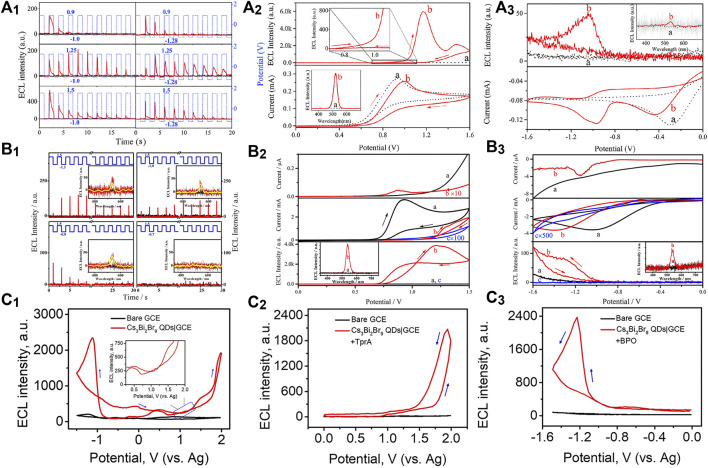

(A
1
) Oxidation initiated transient electrochemiluminescence (ECL), (A
2
) anodic coreactant ECL (10 mA TPrA), and (A
3
) cathodic coreactant ECL (5 mM BPO) of CsPbBr3 NCs|GCE in air-free dichloromethane containing 0.10 M tetra-n-butylammonium hexafluorophosphate (TBAPF6). Reproduced with permission from Huang et al. (2016). Copyright (2016) The Royal Society of Chemistry. (B1) Oxidation initiated transient ECL, (B
2
) anodic coreactant ECL (10 mA TPrA), and (B
3
) cathodic coreactant ECL [100 mM (NH4)2S2O8] of MAPbBr3 NCs|GCE in air-free 0.10 M PBS. Reproduced with permission from Tan et al. (2017). Copyright (2017) American Chemical Society. (C
1
) Annihilation ECL, (C
2
) anodic coreactant ECL (10 mM TPrA), and (C
3
) cathodic coreactant ECL (10 mM BPO) of Cs3Bi2Br9 QDs|GCE in a binary organic solution of acetonitrile and toluene containing 0.05 M TBAPF6. Reproduced with permission from Cao et al. (2019). Copyright (2019) American Chemical Society.